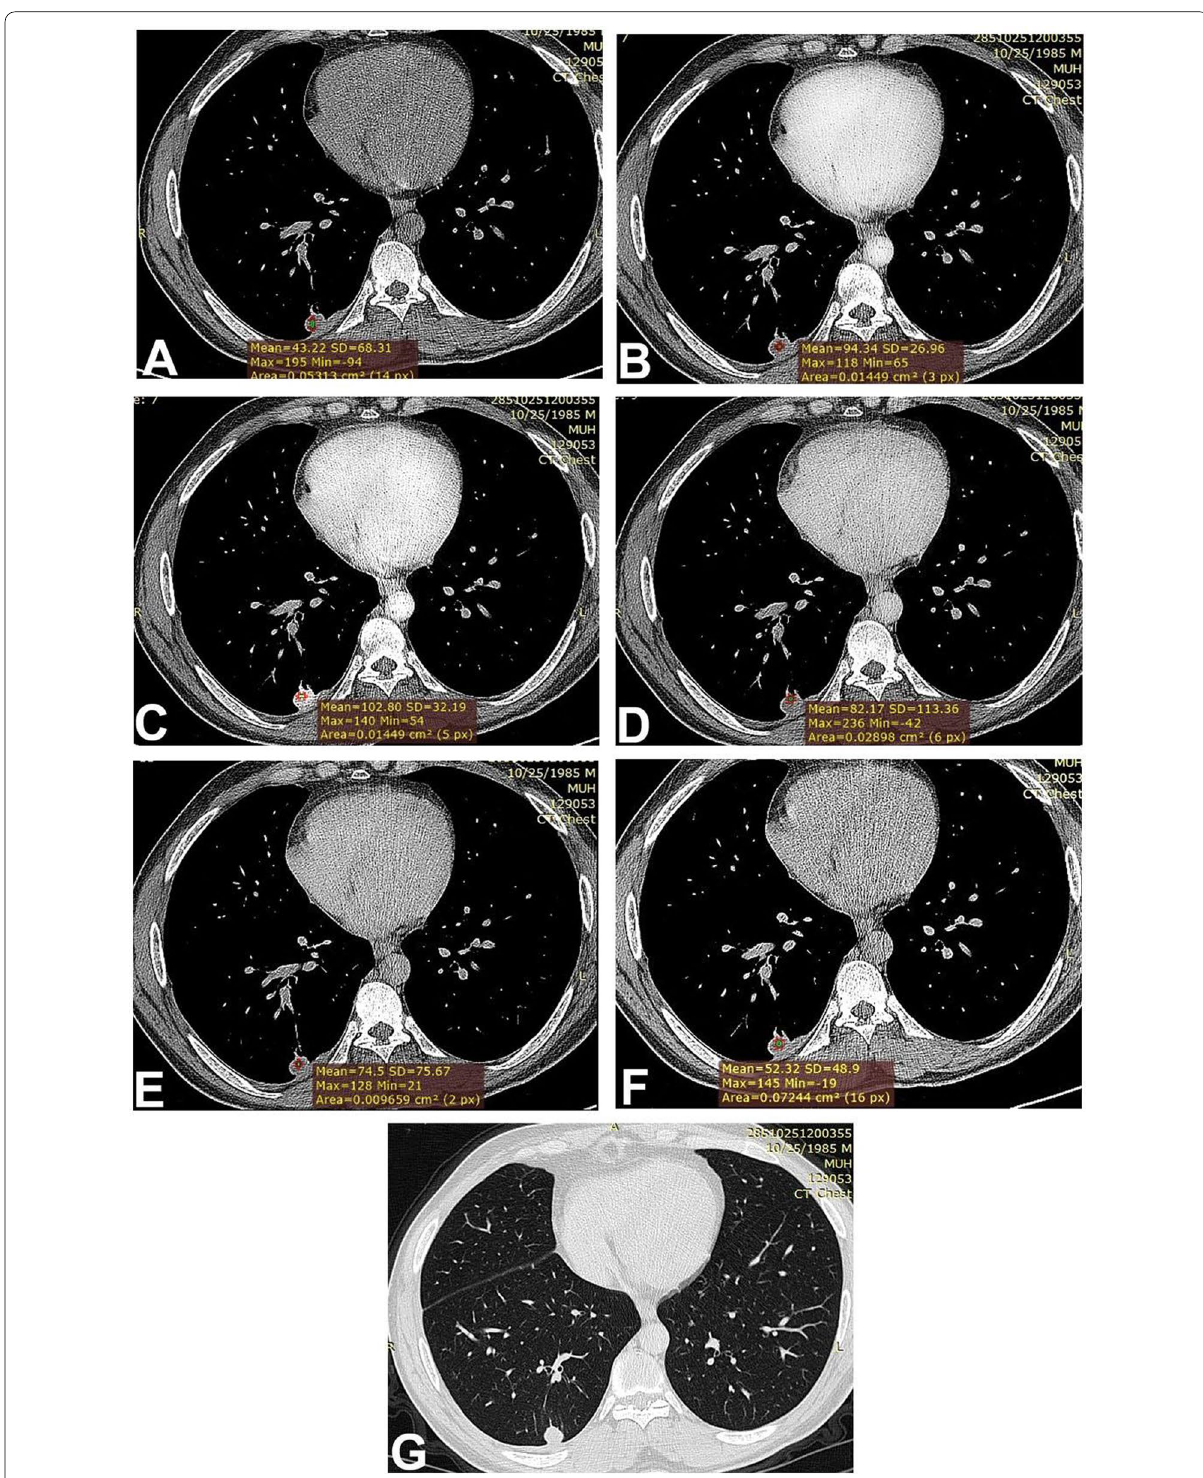
Fig. 2 Dynamic CE‑CT study A Pre contrast axial CT scan of the chest on mediastinal window, B–F contrast enhanced axial CT scans of the chest on mediastinal window obtained 1,2,3,4 &15 min respectively after contrast injection: All figures showed: Well defined pulmonary nodule with regular margin in right lower lung lobe measured 1.2 cm shows mean pre contrast enhancement of 43 HU, mean peak enhancement (after 2 min) of 102 HU and net enhancement of 59 HU. G Axial CT scan of chest in pulmonary window showing the same pulmonary nodule with regular borders in right lower lung lobe. Pathological diagnosis: Metastatic nodule from ovarian